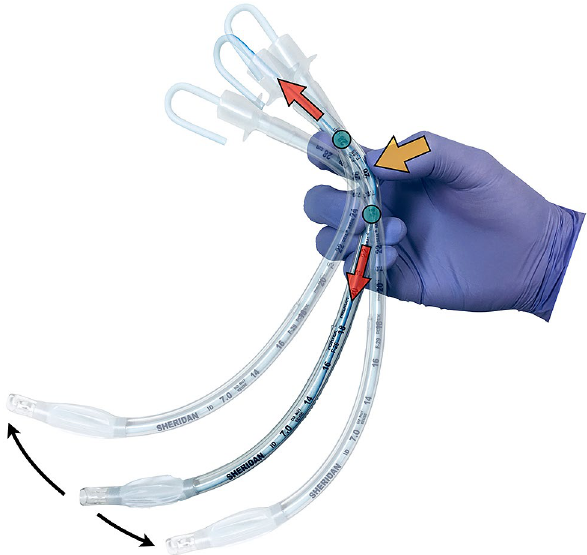
Figure 1. Effect of stylet angulation in the sagittal plane at the operator’s holding position. The holding force of the right thumb (yellow arrow) is divided into vectors in a longitudinal direction (red arrows) and acts on the